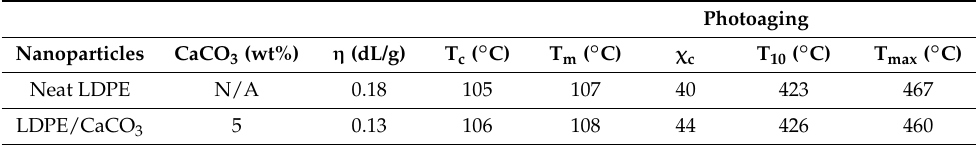
Table 3. Thermal properties of PE/CaCO 3 nanocomposites after photoaging.